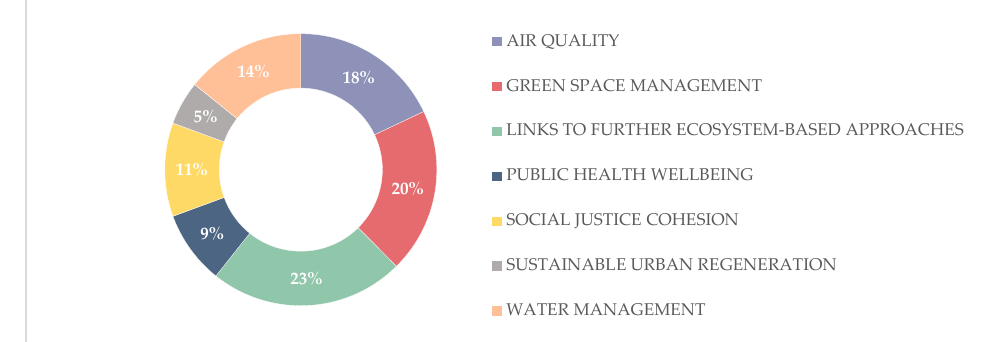
Figure 7. Distribution of NbS ecosystem services.